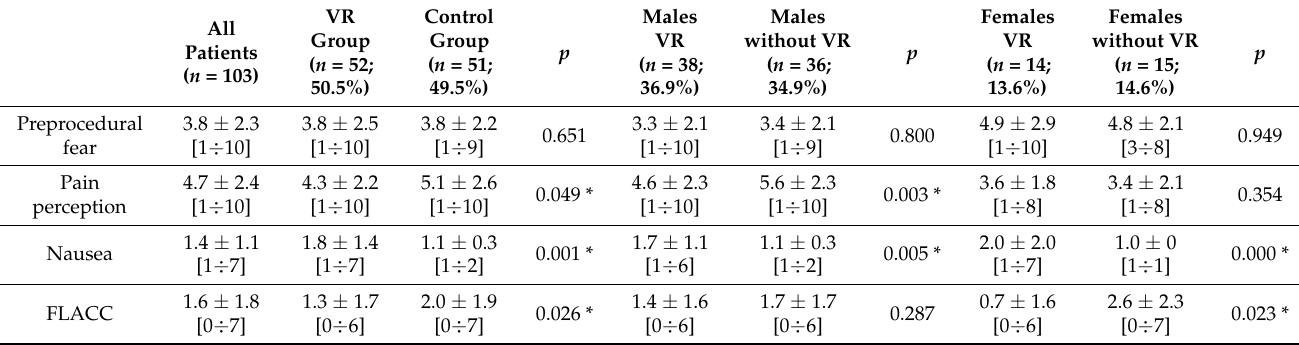
Table 2. Analyzed ailments associated with cystoscopy in various study groups. The results are presented as mean, standard deviation and